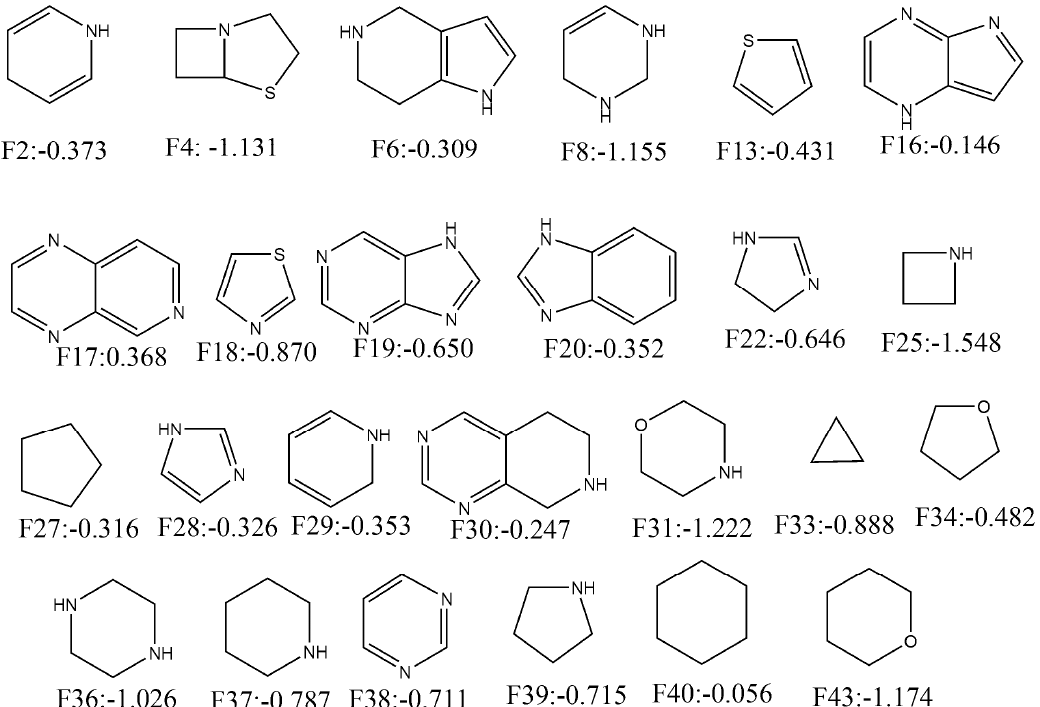
Figure 5. Fragments depicting positive contribution for ERK-1/2 inhibition with their average confidence scores.